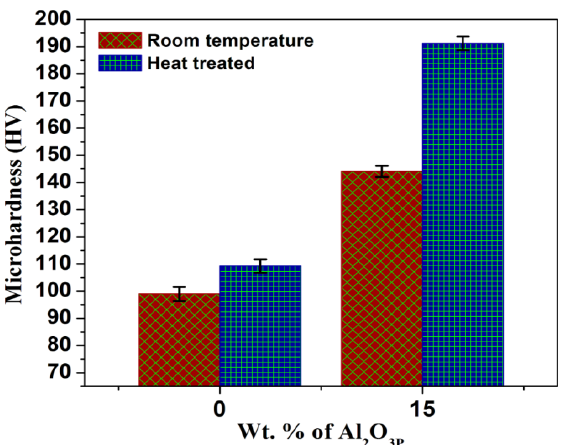
Figure 4. Comparisons of microhardness values of Al2014 and Al2014-15 wt.% of Al 2 O 3 composite with a fine particle, before and after heat treatment condition.